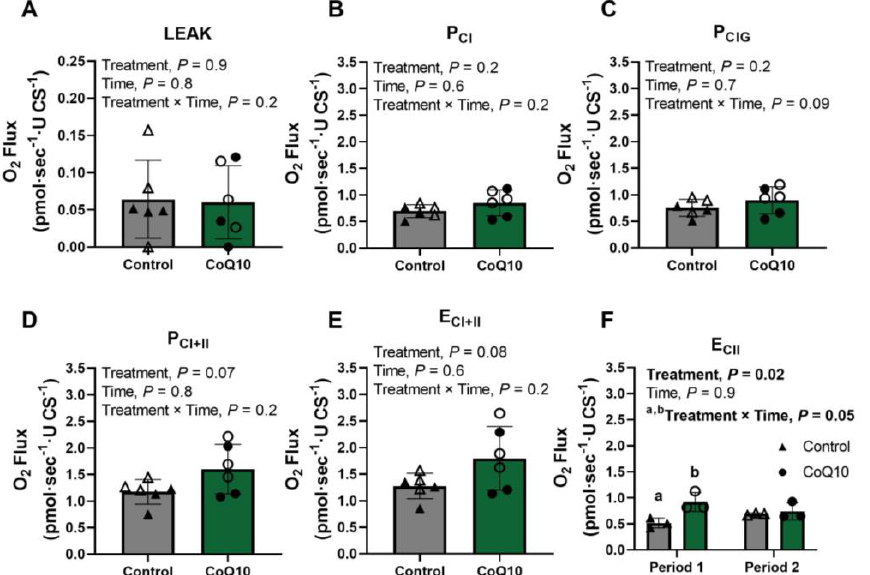
Figure 3. ( A – F ) Intrinsic (relative to CS activity) mitochondrial capacities in the gluteus medius of fit Thoroughbred horses before and after 30 d supplementation of CoQ10 or control diet. Open circles represent horses on the CoQ10 supplement during the first supplementation period, and closed circles represent horses on the CoQ10 supplement during the second supplementation period. Open triangles represent horses on the control diet during the second supplementation period, and closed triangles represent horses on the control diet during the first supplementation period. Within periods, different letters indicate significant treatment differences.